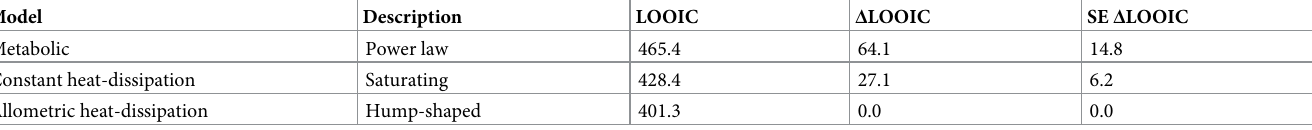
Table 2. Comparison of three alternative allometric locomotion models that predict the realised travel speeds of animals as a function of their body mass and loco- motion mode.